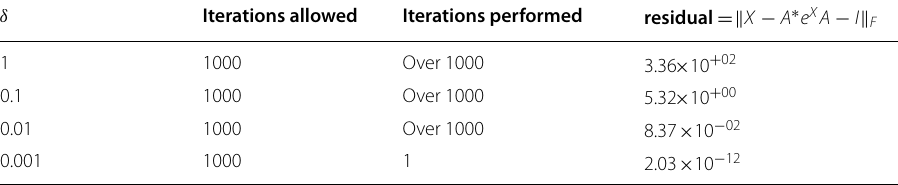
Table 1 Summary of Results for Example 4 for different δ with X 0 = I and Z 0 =